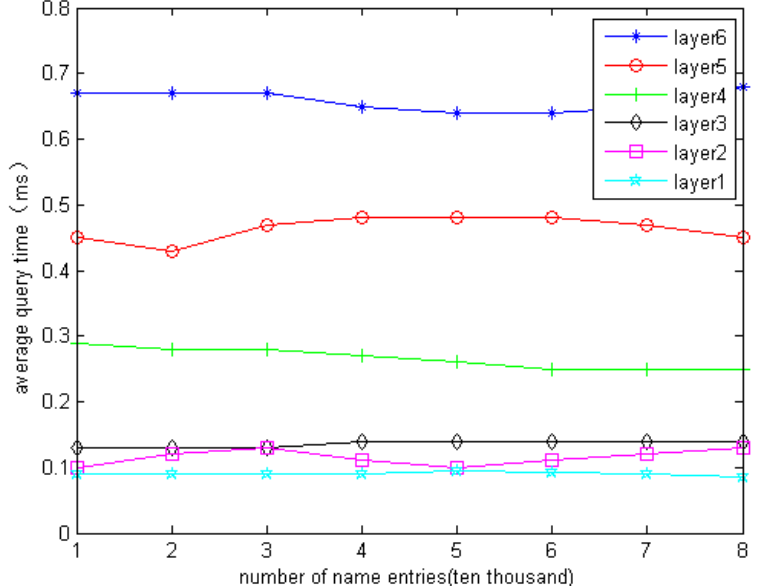
Figure 10. Comparison of query time of di ff erent layers in the mixed naming method.